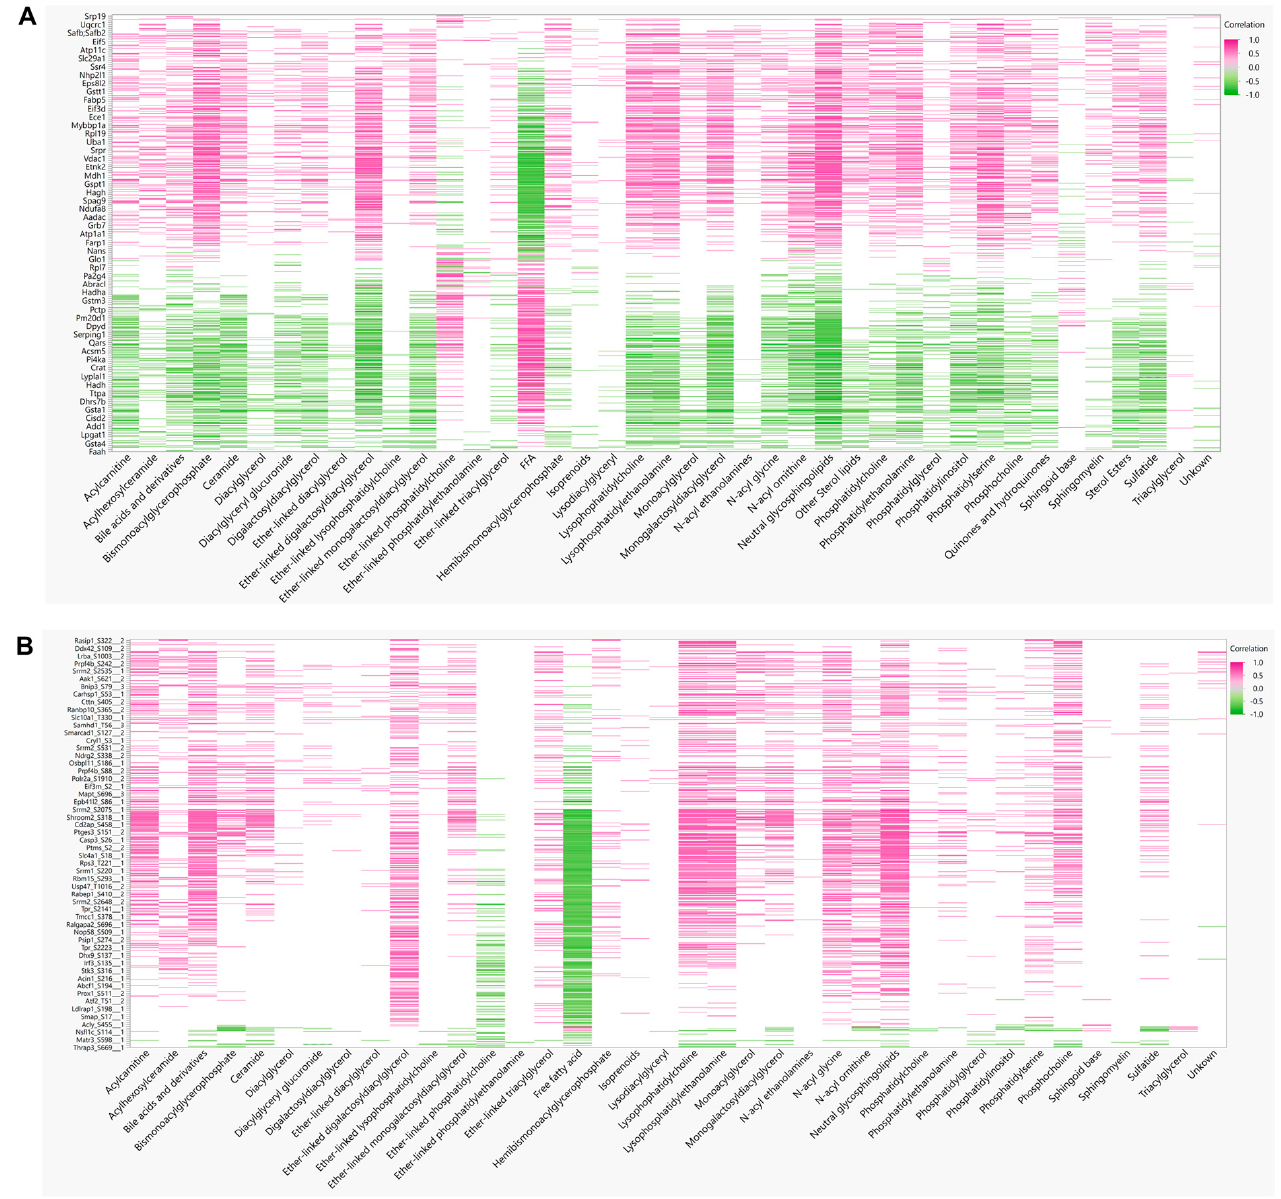
Figure 7. Protein–Lipid correlations. ( A ) Pearson correlation matrix between 38 lipid classes and 255 significant proteins, and ( B ) 649 significant phosphosites.